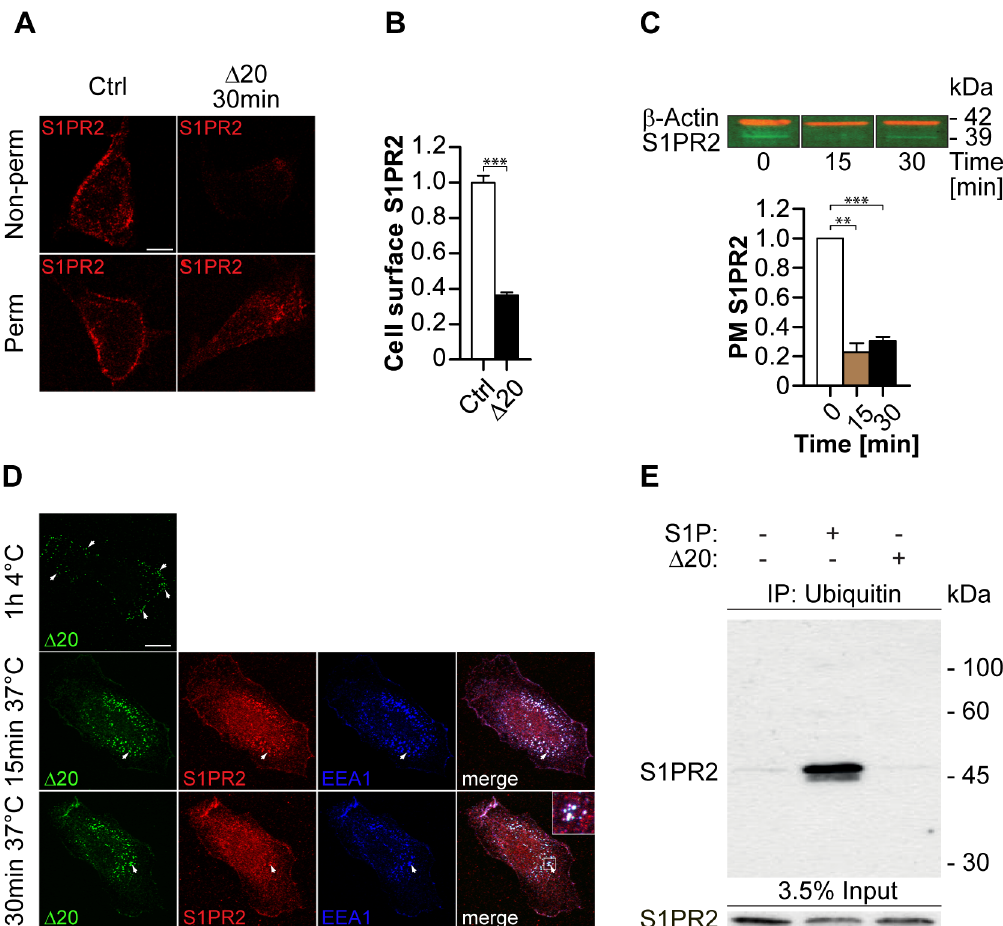
Figure 3. S1PR2 is internalized upon Nogo-A- D 20 binding. (A) Representative confocal micrographs of 3T3 cells stained alive (Non-perm) or fixed (Perm) for S1PR2 before (control) and 30 min after D 20 treatment at 37 u C. (B) Mean fluorescence intensity quantification of the cell surface staining shown in (A). (C) Addition of D 20 downregulates cell surface S1PR2 in 3T3 plasma membranes (PM): immunoblot and relative quantification thereof. Loading control: b -Actin. (D) Representative confocal micrographs of 3T3 cells incubated with 1 m M HA-tagged D 20 for 1 h at 4 u C (pulse), which were then subsequently chased for 15 and 30 min at 37 u C. Cells were stained with an anti-HA ( D 20), S1PR2, or EEA1 antibody (early endosomes). Arrows indicate cell surface-bound D 20 (top panel) or colocalization of D 20 and S1PR2 in early endosomes (middle and bottom panel). The inset panel shows an enlarged view of the boxed region. (E) Western blot analysis of ubiquitinated and non-ubiquitinated protein fractions of 3T3 cells 30 min after D 20 or S1P treatment. Data shown are means 6 SEM ( n =3–6 experiments; ** p , 0.01, *** p , 0.001). Scale bars: (A,D) 50 m